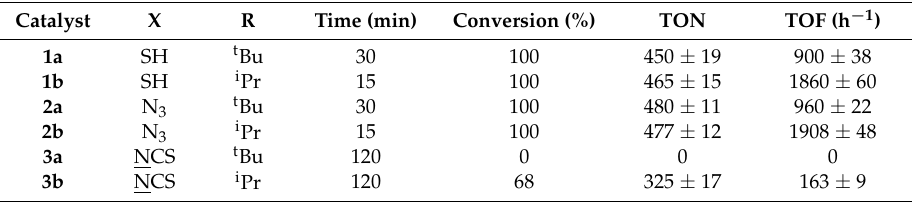
Table 1. Turnover number (TON) and turnover frequency (TOF) obtained from the catalytic hydroboration of CO 2 with HBcat catalyzed by [2,6-(R 2 PO) 2 C 6 H 3 ]NiX complexes 1 .